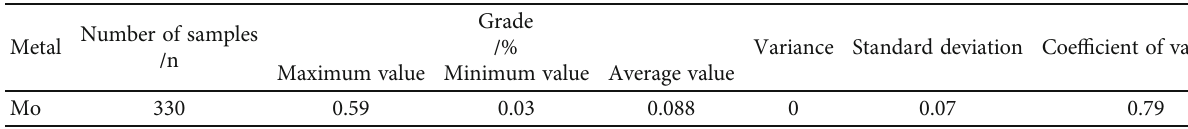
Figure 11: Drill hole e ff ect and 3D model of the ground surface. Table 3: Sample data statistics.